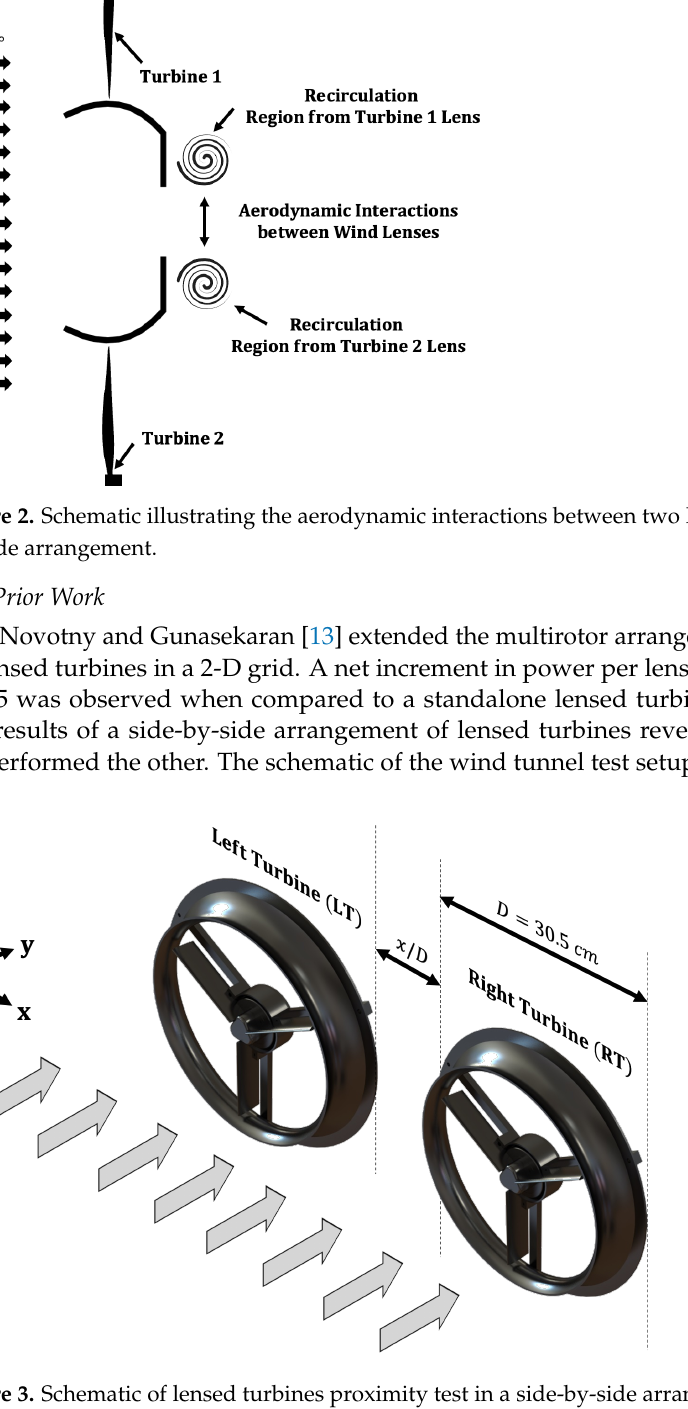
Figure 3. Schematic of lensed turbines proximity test in a side-by-side arrangement